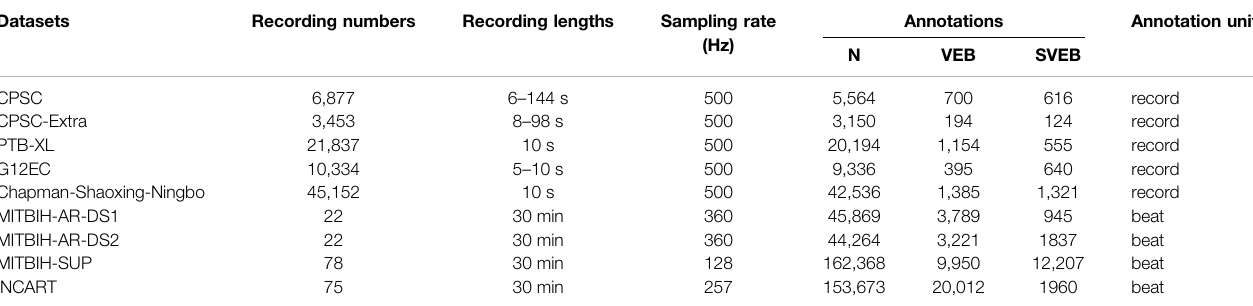
TABLE 2 | The compositions of the